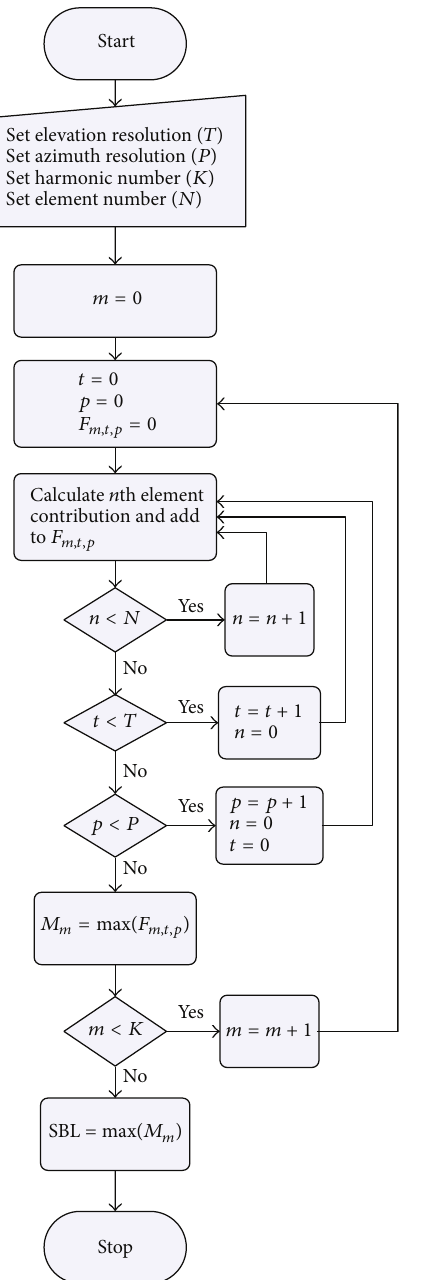
Figure 2: The illustrative flowchart of the SBL method.